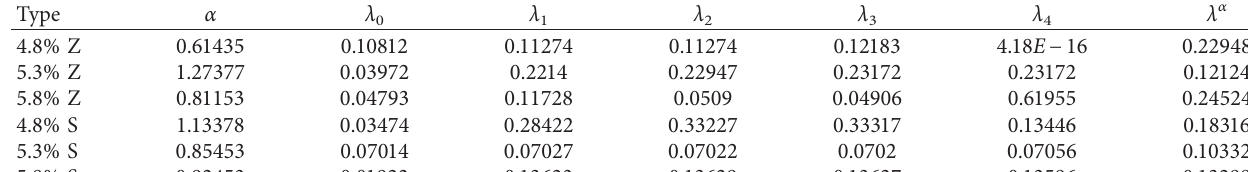
Table 6: Damage parameters in process of uneven freeze-thaw damage.